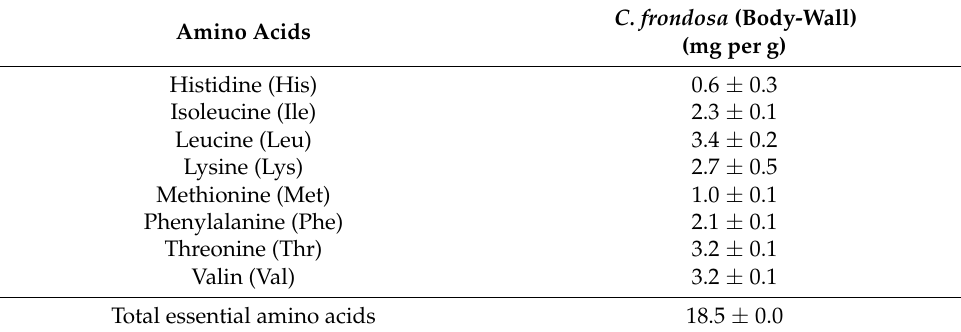
Table 3. Amino acid composition (mg per g) of wet weight orange-footed sea cucumber ( Cucumaria frondosa ) body-wall (average ± SD, n =